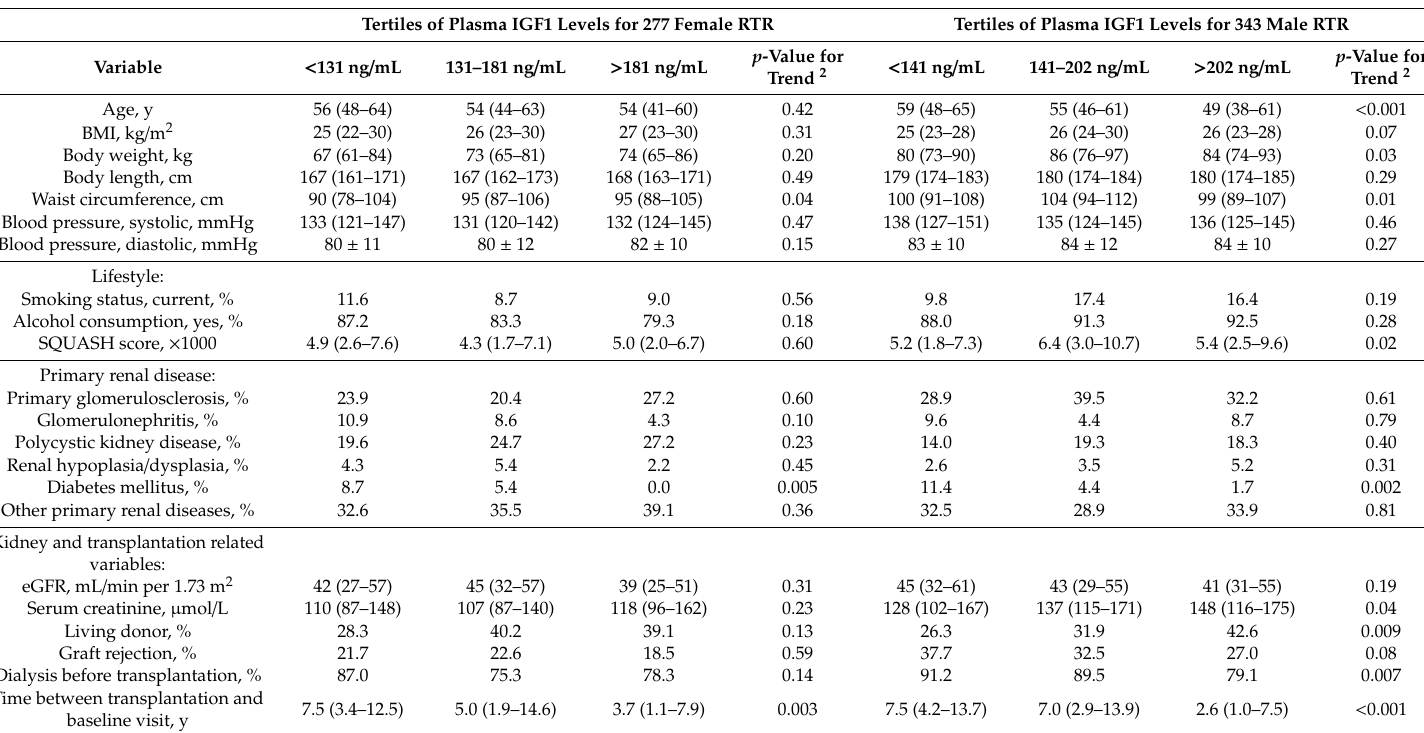
Table 1. Baseline characteristics according to tertiles of plasma IGF1 levels in female and male RTR 1